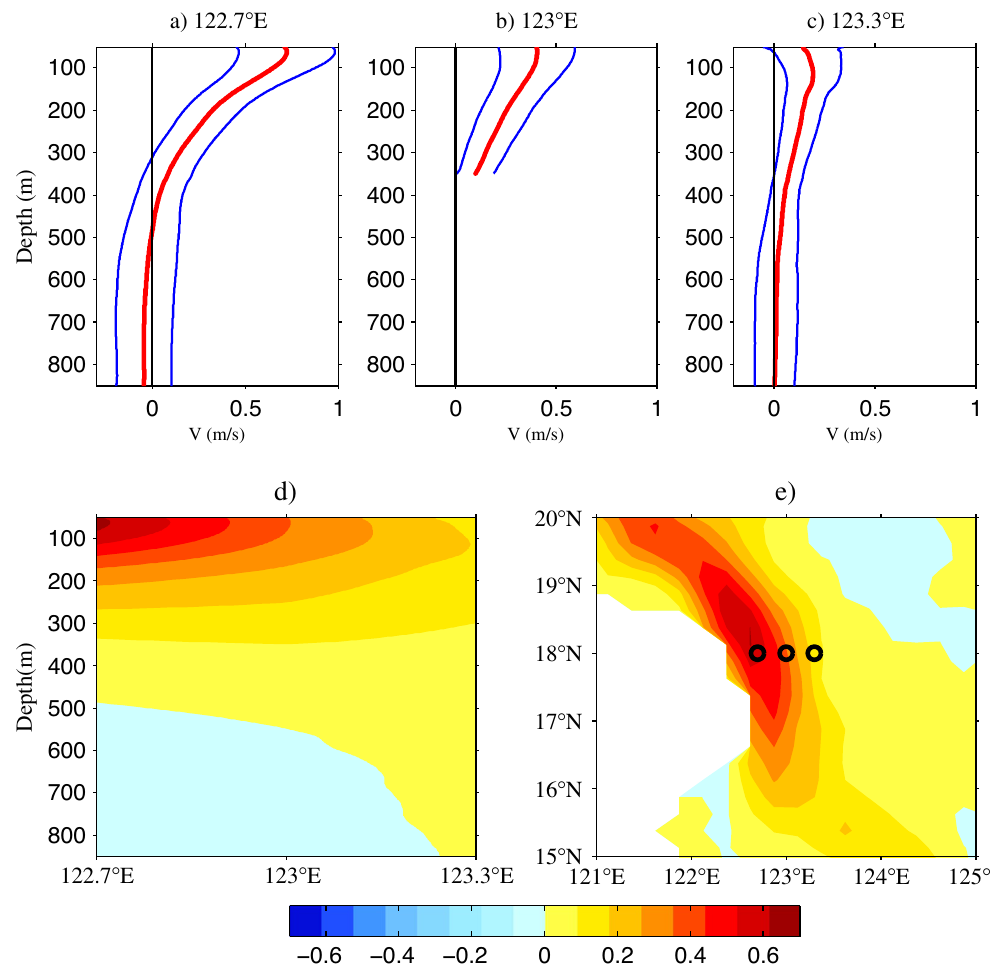
Figure 2. Mean meridional velocities (red lines, m/s) and corresponding standard deviations (blue lines) at ( a ) 122.7° E, ( b ) 123° E, and ( c ) 123.3° E along 18° N. The black lines represent zero velocity. ( d ) Longitude–depth meridional velocities of three moorings at 122.7° E, 123° E, and 123.3° E along 18° N. ( e ) Mean meridional velocities calculated from satellite altimeter data (1993–2019) in the origin region of the KC (units are m/s). Figures are plotted using MATLAB R2012b (http:// www. mathw orks.